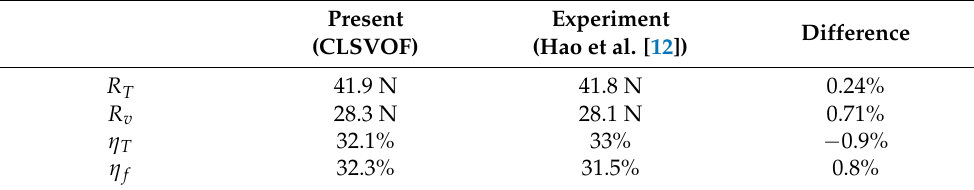
Table 4. Drag and drag